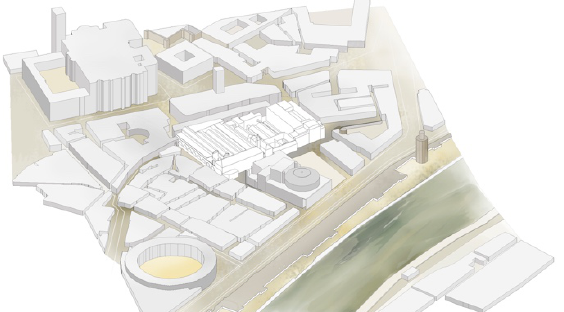
Figure 11. Neighbourhood scale. The use of these perspectives